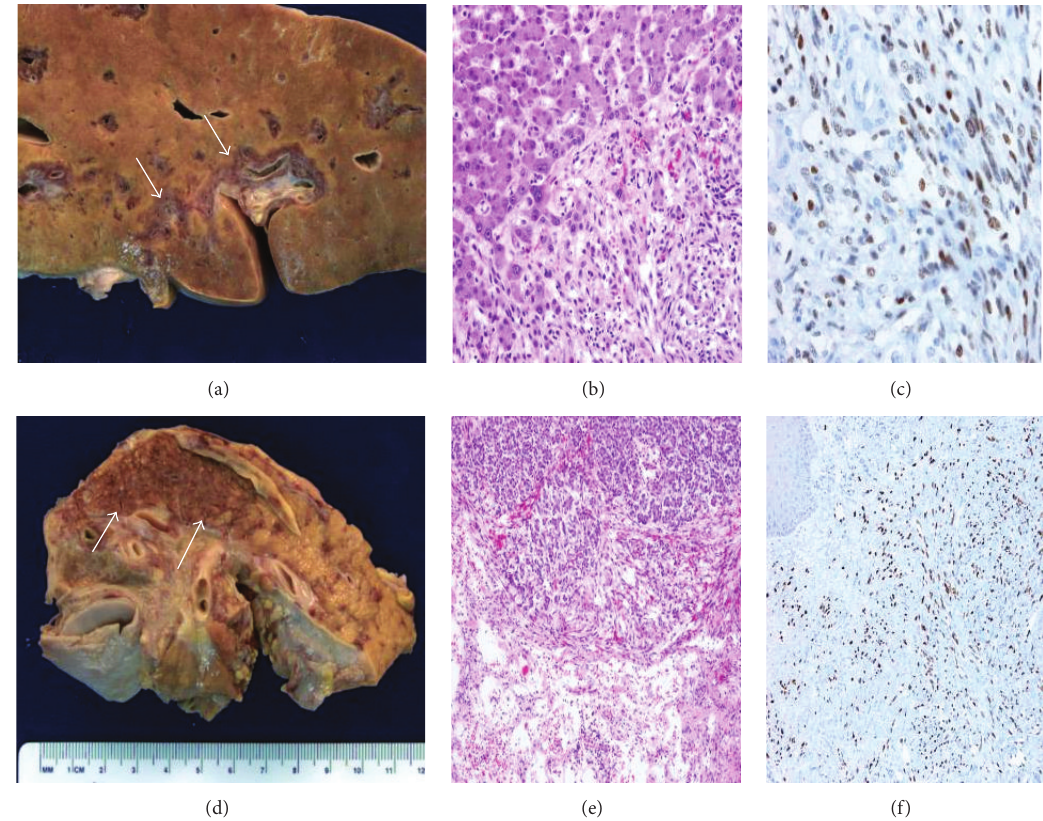
Figure 3: The cut surface of liver shows a well-demarcated perivascular infiltration marked by reddish-brown tumorous tissue (arrows) (a). The head of the pancreas shows a reddish-brown infiltrating lesion (arrows) (d). Representative microscopic sections show spindle cells proliferation involving hepatic lobules ((b) H&E, × 20) and pancreatic acini ((e) H&E, × 10) with positive staining for HHV-8 antibody consistent with Kaposi’s sarcoma ((c),